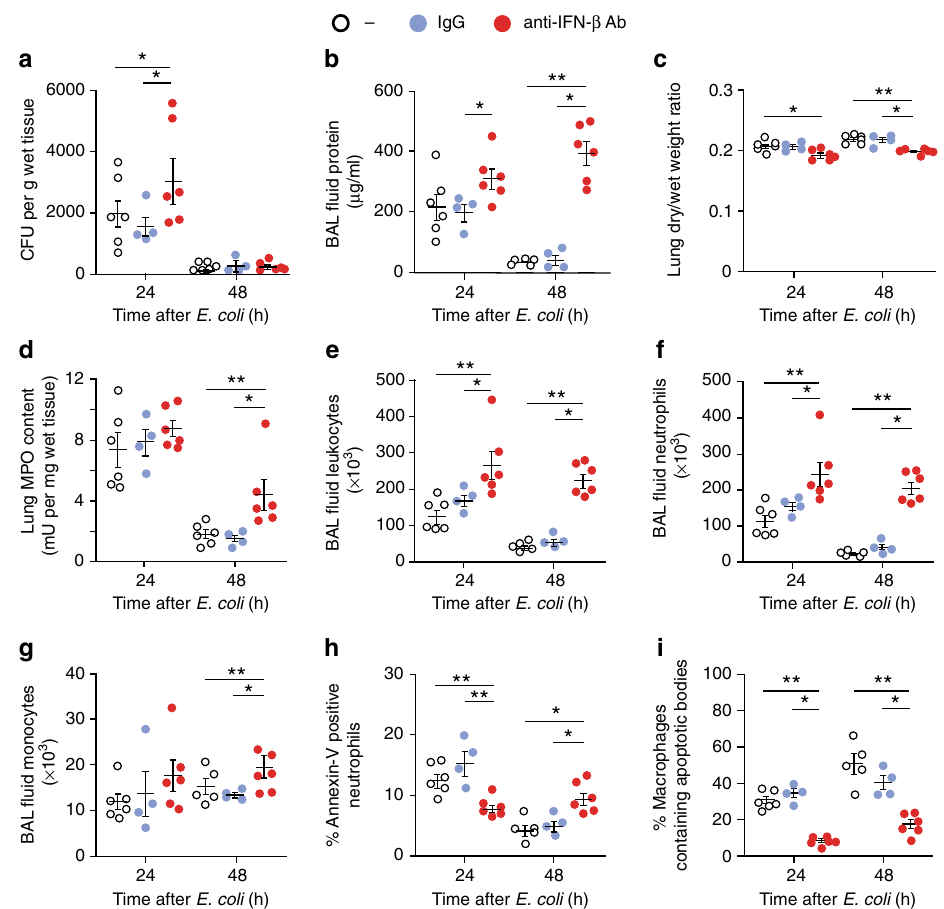
Fig. 3 IFN- β is essential for the resolution of E. coli pneumonia. Female C57BL/6 mice were injected intratracheally with 5*10 6 live E. coli with anti-IFN- β antibody (1 μ g/20 g b.w.) or isotype control (IgG) or saline ( “ - “ ). At 24 or 48 h, lungs were removed without lavage and analyzed for E. coli content ( a ), lung dry-to-wet weight ratio ( c ) and tissue MPO activity ( d ). In separate groups of mice bronchoalveolar lavage fl uid protein concentration ( b ), total leukocyte ( e ), neutrophil ( f ) and monocyte/macrophage numbers ( g ), the percentage of annexin-V-positive (apoptotic) PMN ( h ), and the percentage of macrophages containing apoptotic bodies ( i ) were determined. Results are means ± SEM ( n = 6 mice per group for control and anti-IFN- β , or 4 for IgG). * P < 0.05, ** P < 0.01 (Dunn ’ s multiple contrast hypothesis test). Source data are provided as a Source Data fi